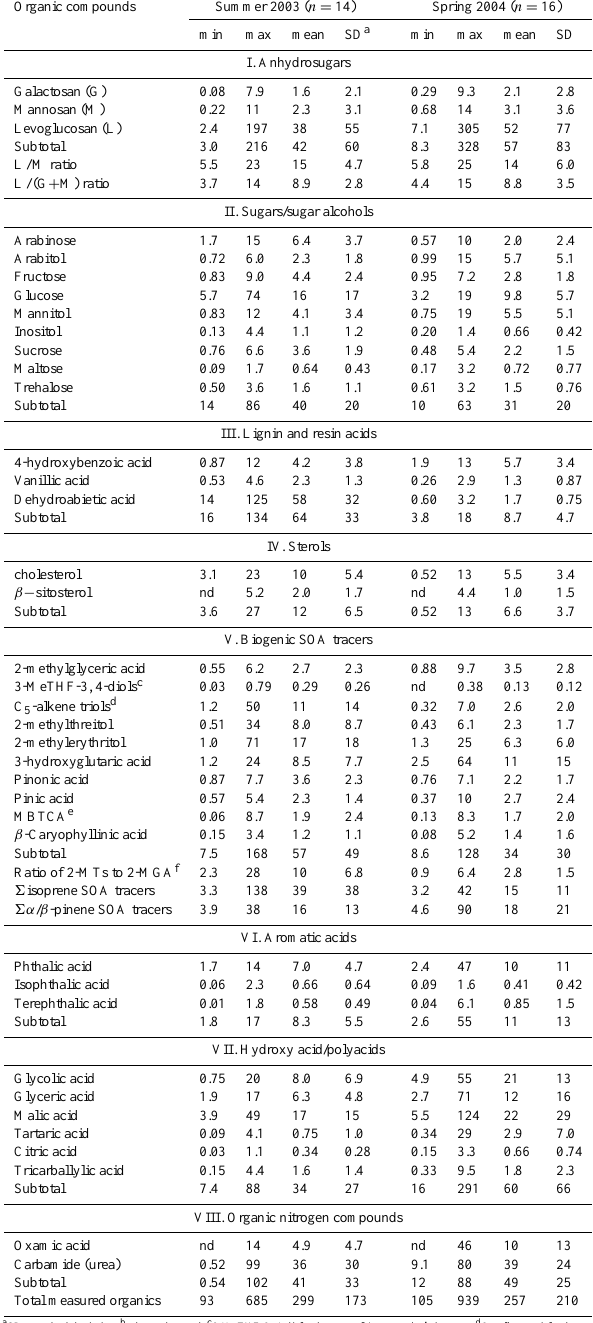
Table 2. Average concentrations and concentration ranges for polar organic species detected in the aerosol samples (PM 10 ) collected by aircraft over central China (ngm − 3 )